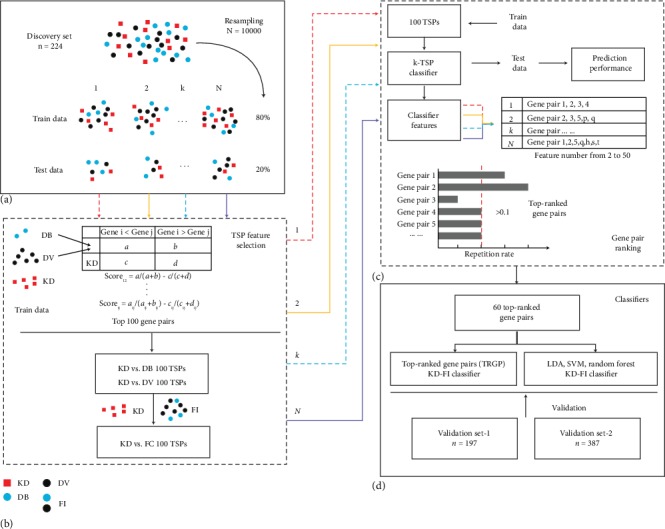
The workflow of the gene pair identification and evaluation for the KD and FI prediction. The workflow has four major analysis steps. (a) Resampling sample space of the discovery set by 10,000 times. Each resampled discovery set is divided into the train data and the test data in a ratio of 8 : 2. (b) Identification of top score gene pairs. (c) Ranking the repeats of the gene pairs form 10,000 k-TSP classifiers. (d) The prediction classifier of KD and FI by the top-ranked gene pairs and validation.